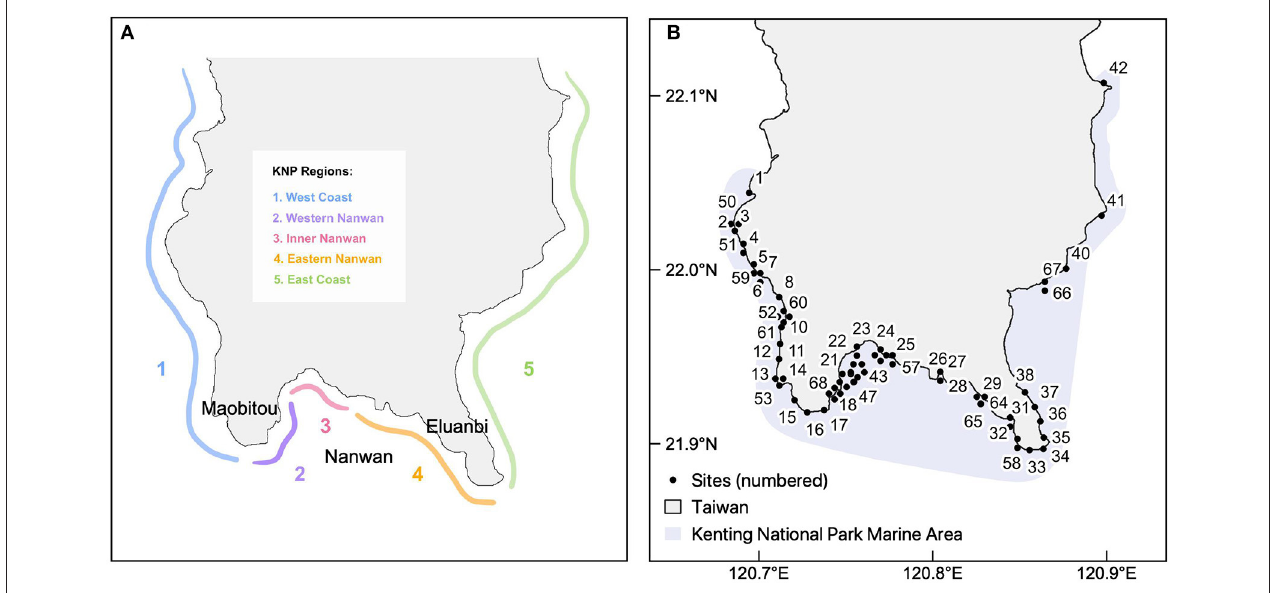
FIGURE 1 | The five geographical regions of the Kenting National Park in southern Taiwan (A) and the 68 study sites (black points) (B)